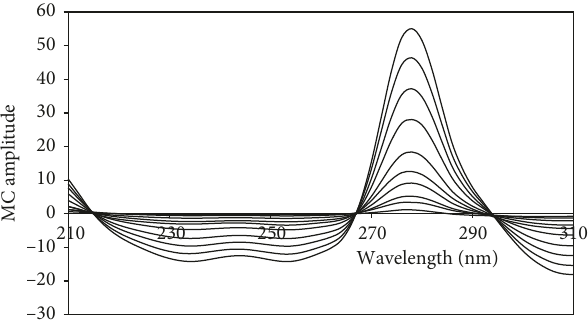
Figure 11: Mean-centered ratio spectra (1, 2, 3, 5, 7, 10, 15, 20, 25, and 30 μ g · mL − 1 ) of pyriproxyfen in methanol as a